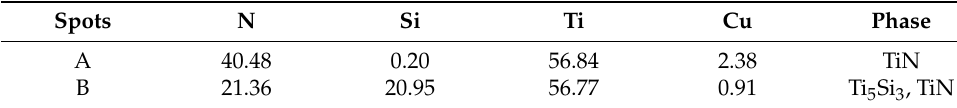
Table 8. Component content of each point in Figure 15b (at %).